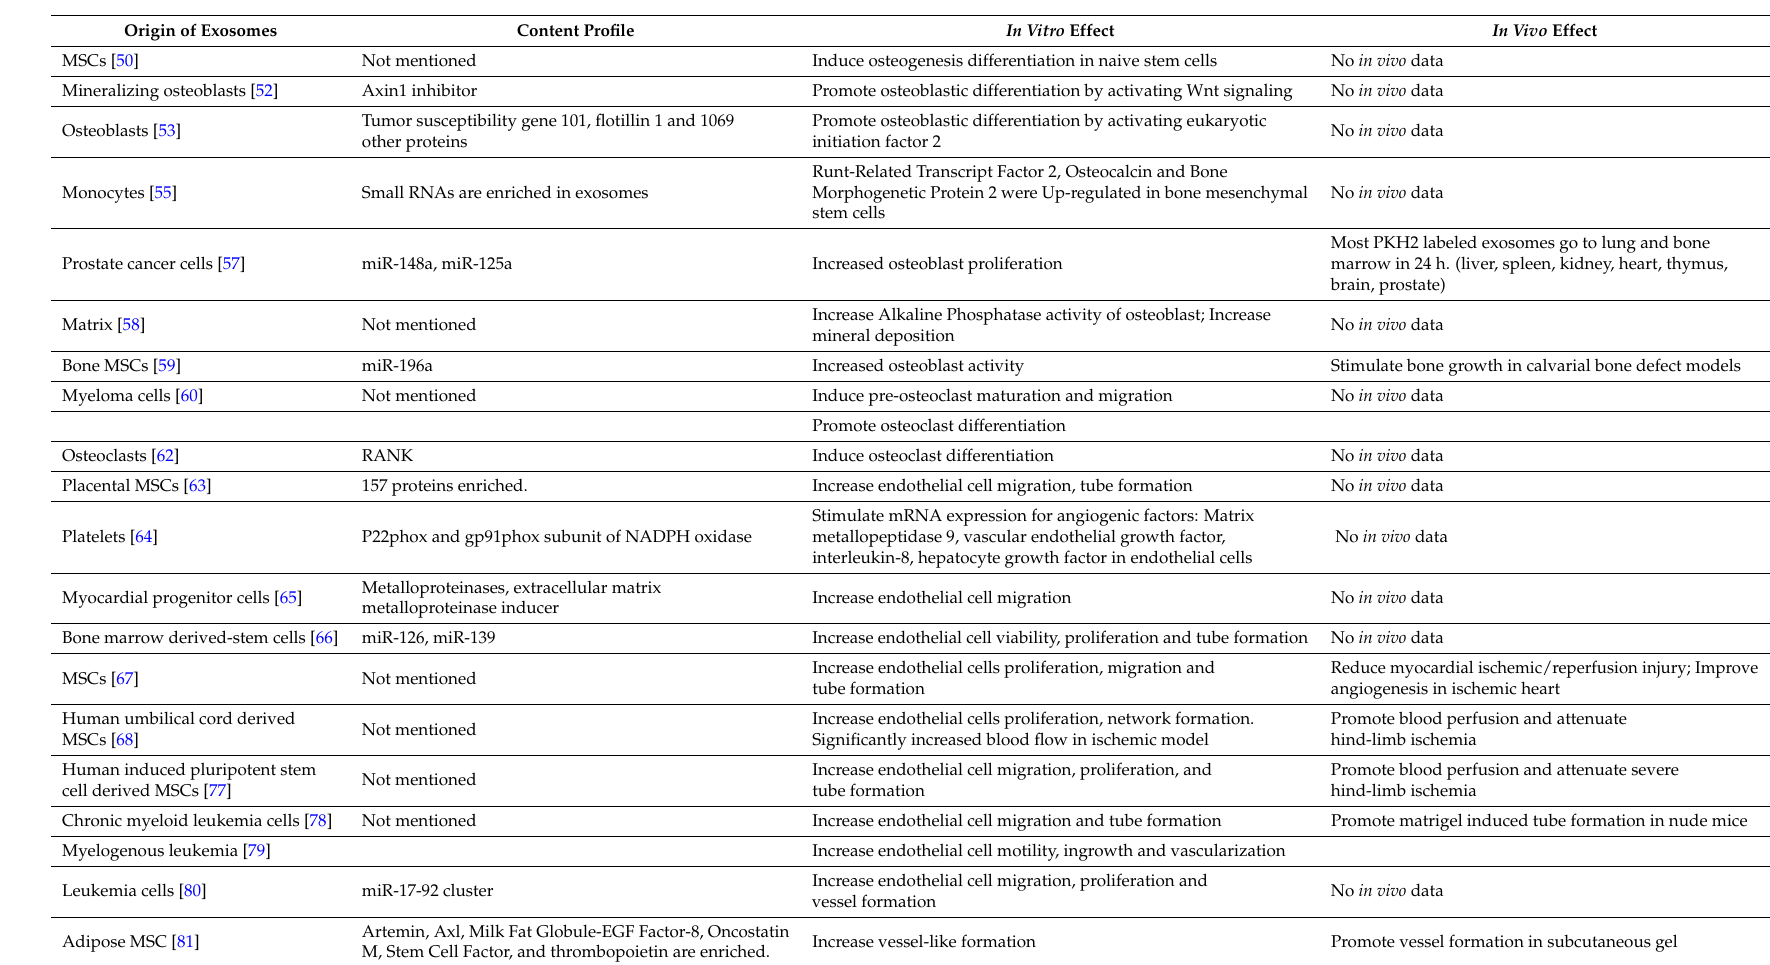
Table 2. Reported roles of exosomes in osteogenesis and